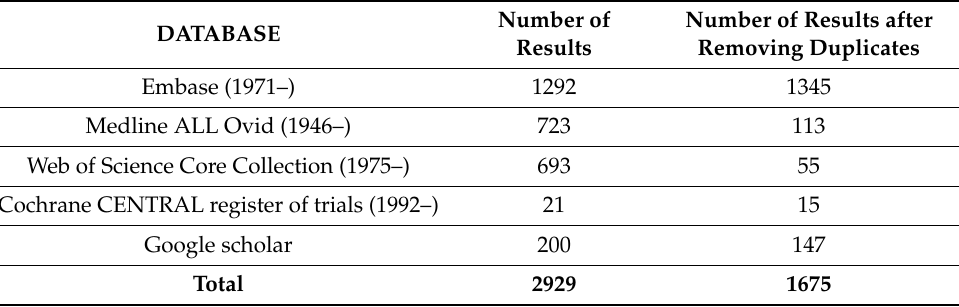
Table A1. Databases searched for research articles. In brackets is the date of inception of the database. The 2nd column shows the number of search results and the 3rd column the number of search results after removing